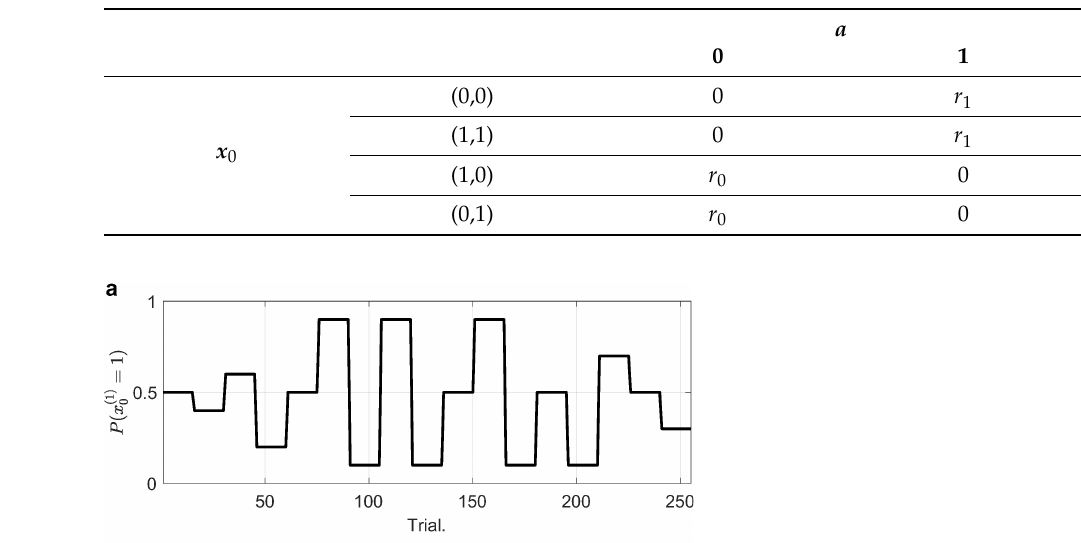
Table 1. Reward table.